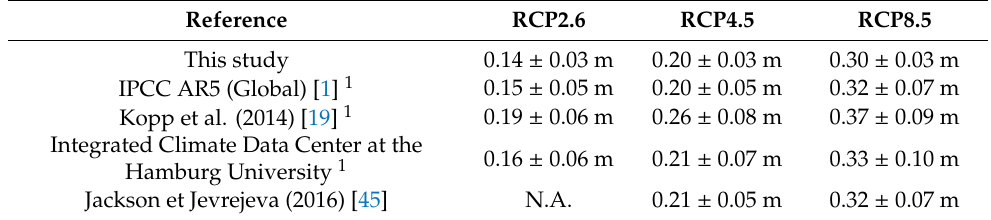
Table 1. Comparison of the global mean of sterodynamic sea-level changes to sea-level rise by 2100. The global mean of sterodynamic sea-level changes is theoretically equal to the thermosteric contribution, but some numerical di ff erences can be found (see text). The uncertainties below are those used as input for the global or regional sea-level change computations. Hence, they correspond to one standard deviation of AOGCMs outcomes in this study and in Jackson and Jevrejeva 2016 [45], but the 5–95% range of AOGCMs outcomes in the AR5, in the Integrated Climate Data Center at the Hamburg University dataset and in Kopp et al. (2017)